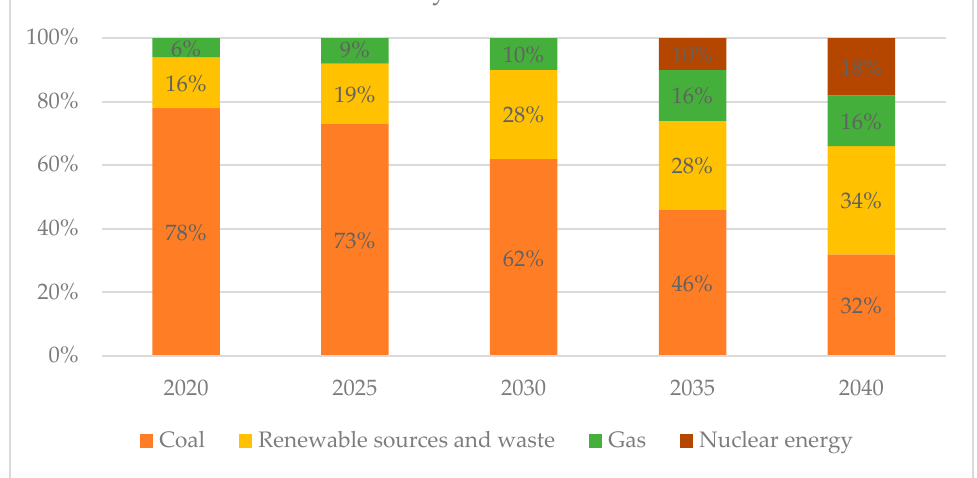
Figure 9. The forecast of electricity sources in Poland in 2020–2040. Source: authors’ own studies, developed from [73].